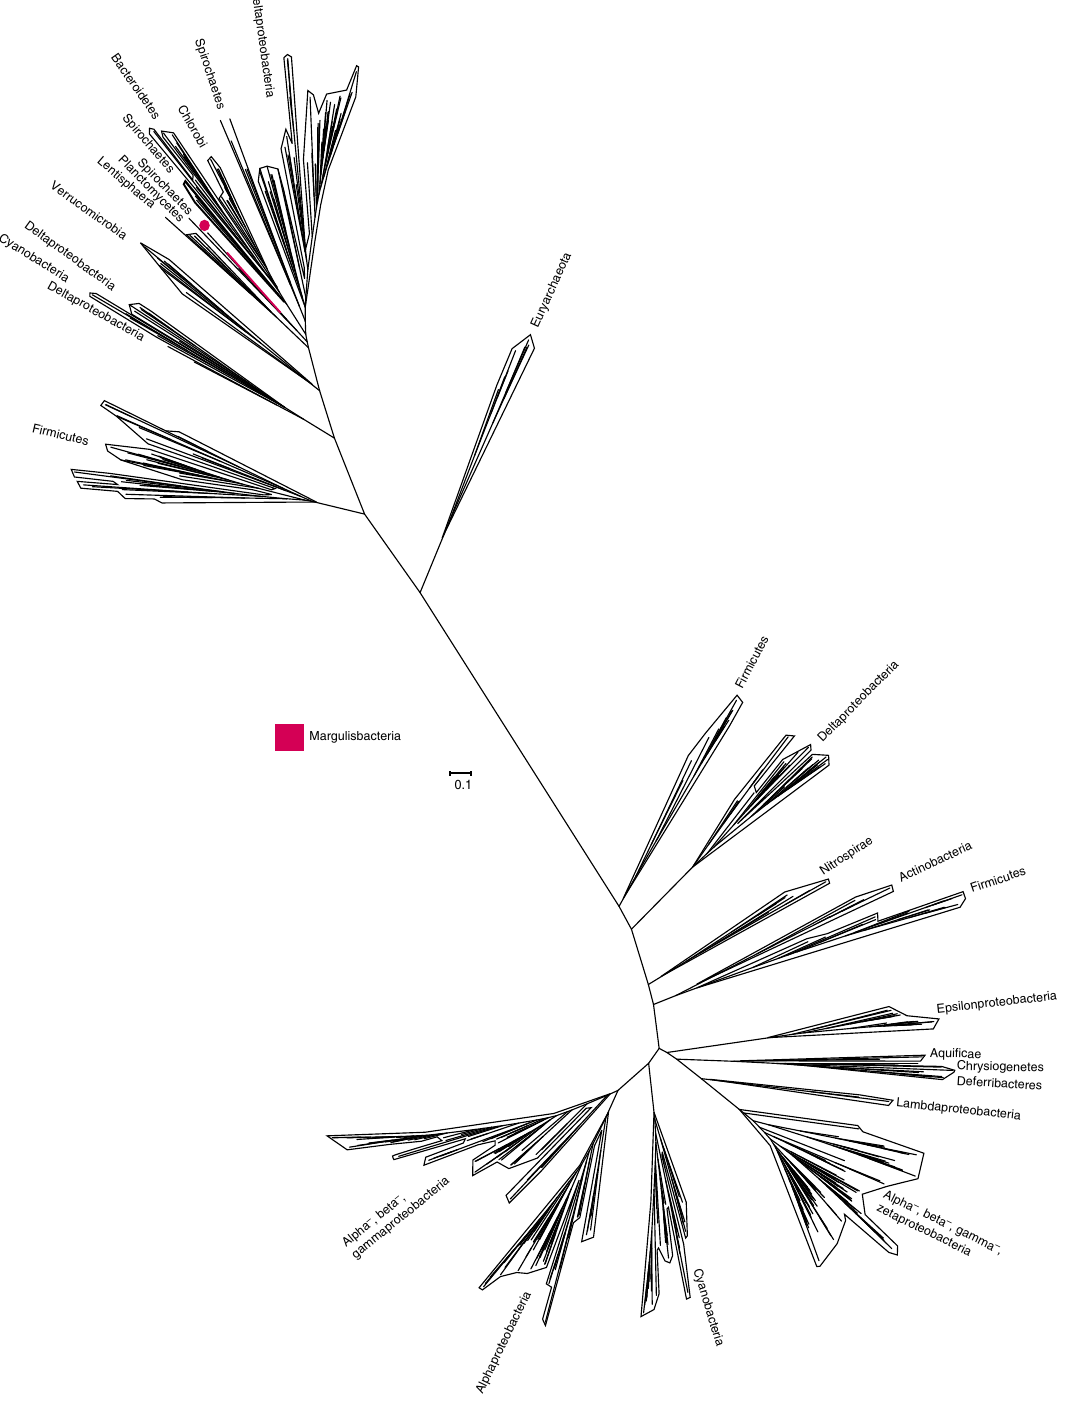
Fig. 6 Phylogenetic tree of concatenated nitrogenase subunits NifHDK. Maximum likelihood tree indicating the branching of the Ri fl emargulisbacteria NifHDK together with anaerobic taxa. Scale bar indicates substitutions per site. Branches with a posterior support of below 0.5 were collapsed. The tree and underlying alignments are available with full bootstrap values as pdf and in Newick format in Supplementary Data